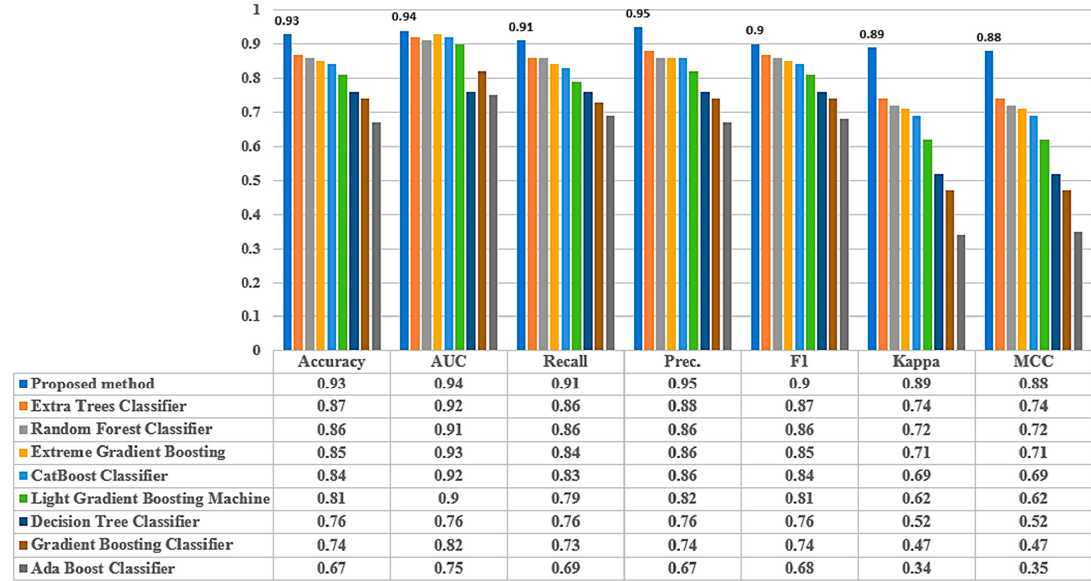
Figure 21. Performance evaluation of studied tree-based ML models.